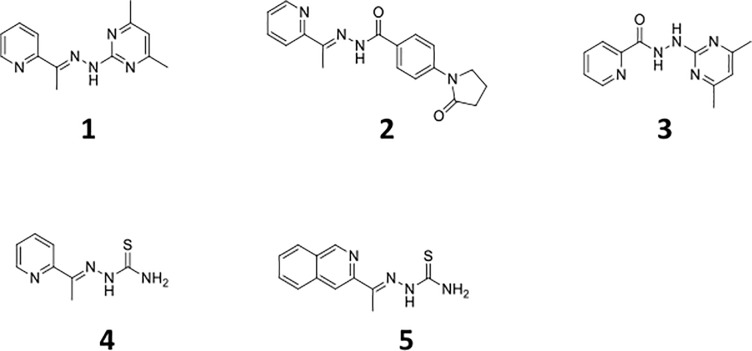
Structure of analogs used in this study.